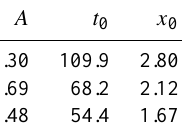
Table 1. Parameters of the fitted cosine functions for mean, stan- dard deviation ( σ ) and coefficient of variation (CV) of the daily rain sums of the KNMI stations between 15 February 1979 and 15 February 2009 using a 90 day moving averaging window. 1 /f A t 0 x 0 mean 365 0.30 109.9 2.80 σ 365 0.69